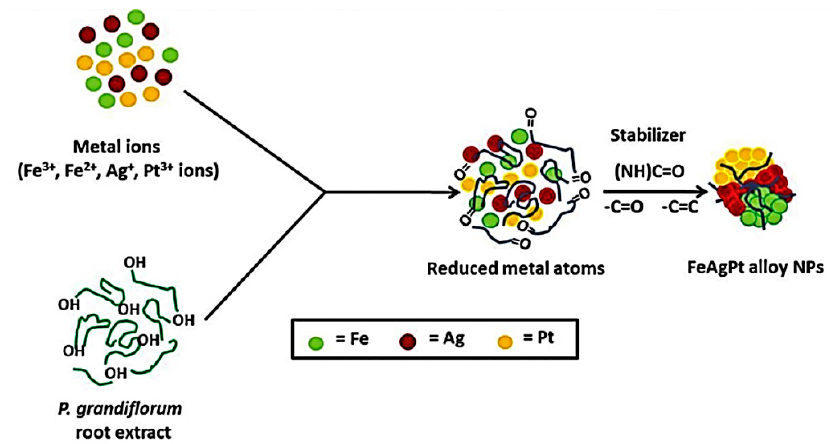
Figure 9. Schematic depiction of the role of P. grandiflorum in the Fe ‐ Ag ‐ Pt alloy NP formation. Reproduced from [27], with permission from Elsevier, 2017.